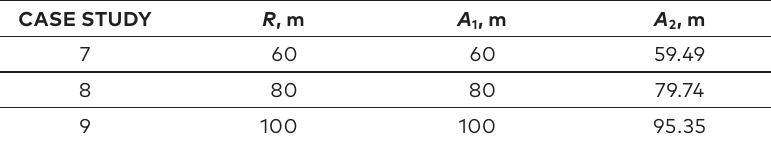
Table 7. Design Bloss curve: scale factors A 1 and A 2